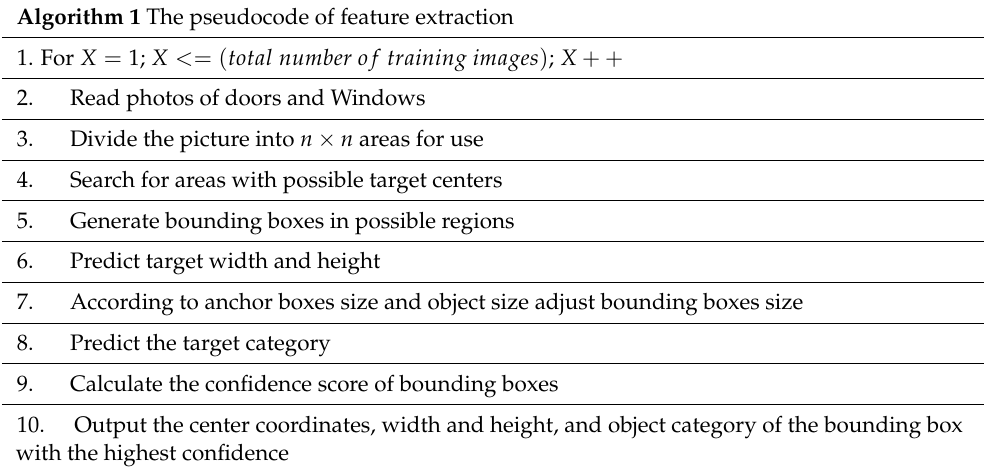
Algorithm 1 The pseudocode of feature